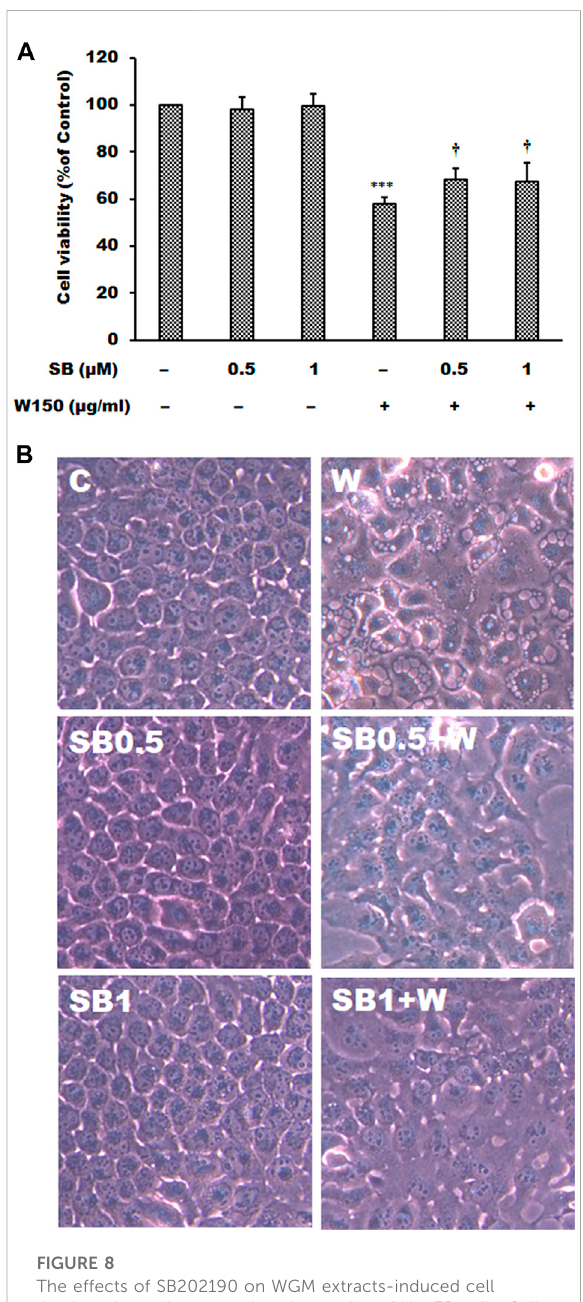
FIGURE 8 The effects of SB202190 on WGM extracts-induced